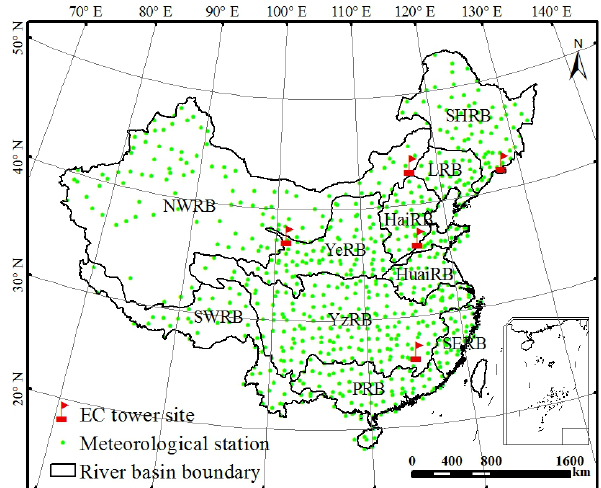
Fig. 2. Locations of flux tower sites (red flags), 753 national basic meteorological stations (green circles), and boundaries of 10 river basins (black lines): SHRB – Songhua River basin; LRB – Liaohe River basin; HaiRB – Haihe River basin; YeRB – Yellow